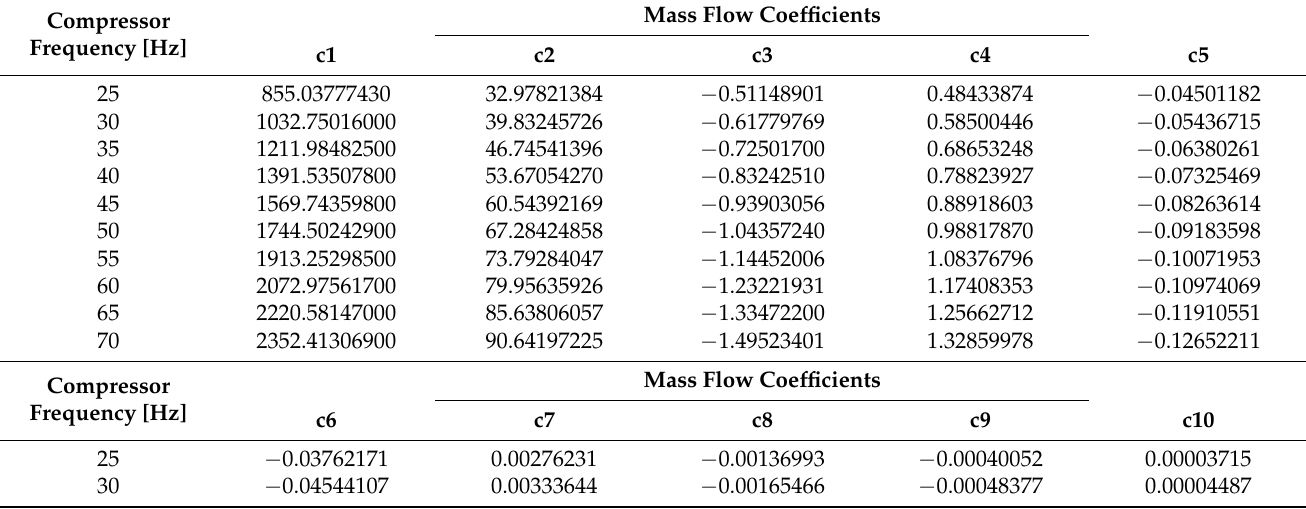
Table A1. Mass flow coefficients at different compressor